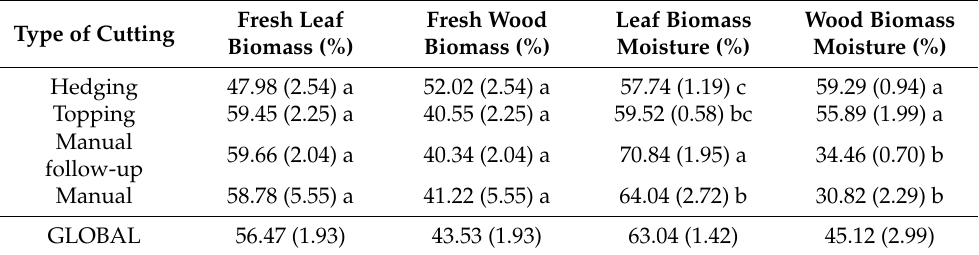
Table 7. Percentage of fresh weight of biomass of leaves and wood of the cut branches and their percentage of moisture, by type of cutting and globally. Data are expressed as averages, with standard errors in parentheses. Different letters in a column indicate significant differences between types of cutting for each parameter 1 according to Fisher’s LSD test ( p <